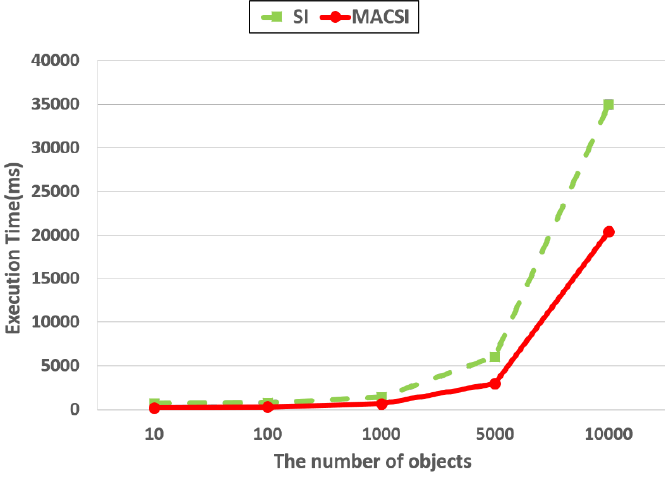
Figure 27. The effect of object number on the semantic trajectory query performance.